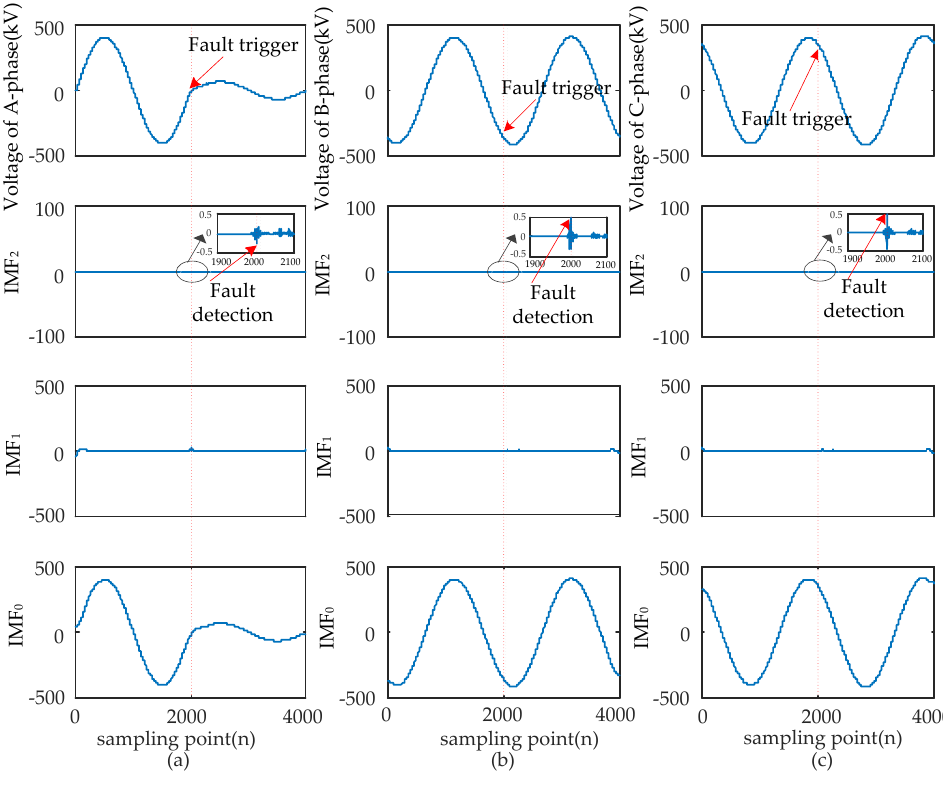
Figure 5. AG fault signal’s modes extracted by the EWT are shown as follows: ( a ) A-phase voltage and its IMFs; ( b ) B-phase voltage and its IMFs; ( c ) C-phase voltage and its IMFs.